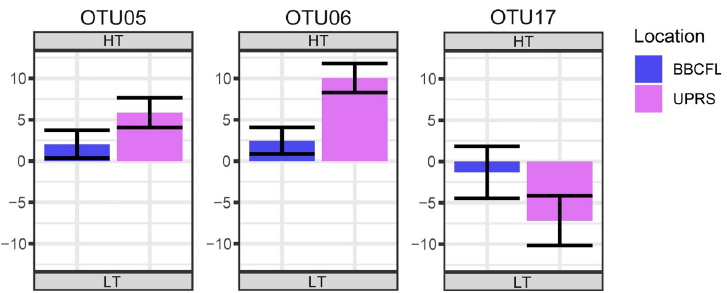
Fig 1. Statistically significantly ( q � 0 . 05 )different abundant fungal OTUs considering interactions of location (BBCFL, UPRS) and tolerance group (HT, LT) as an effect where effects due location had the same direction. The differences in abundance of fungal OTUs are shown as log2 fold changes for each tolerance interaction. Positive values represent higher abundance in HT cattle, negative values represent higher abundance in LT cattle. Bars in blue and purple represent farms BBCFL and UPRS, respectively. Error bars represent the 95% confidence